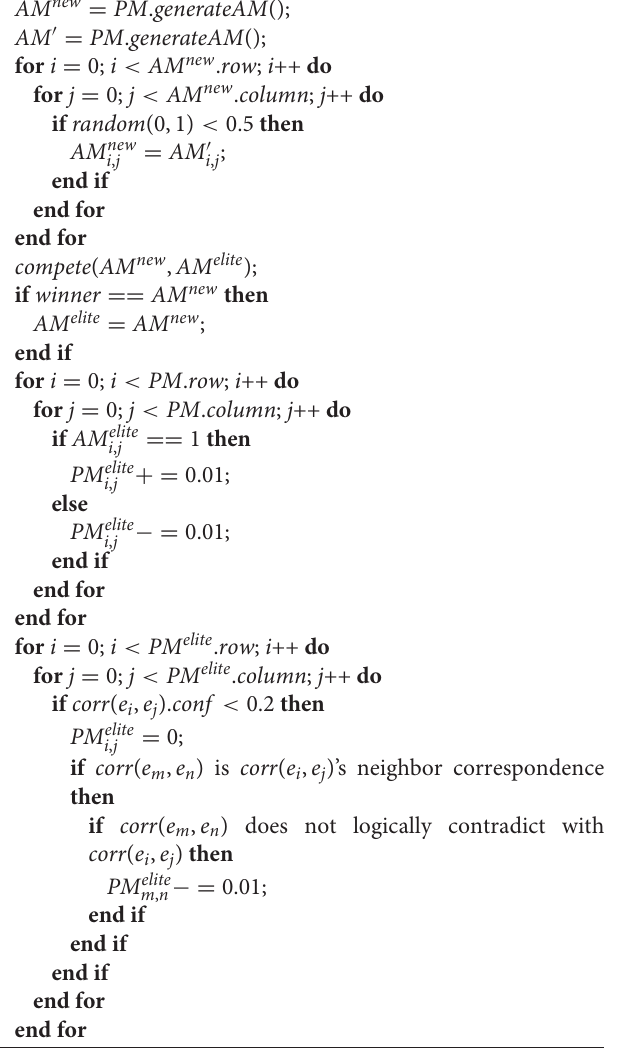
Algorithm 3 Updating Probability Matrix